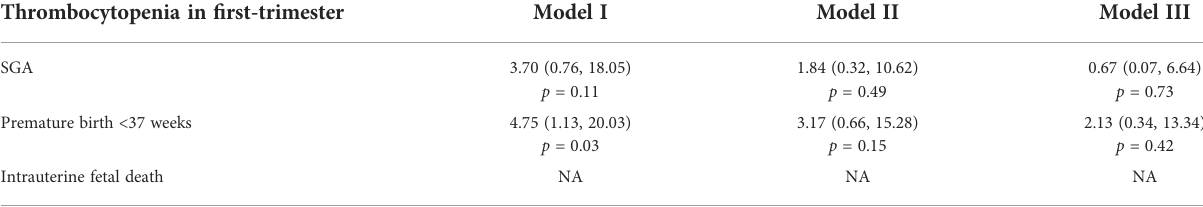
SGA, small for gestational age. AdjustImodeladjustfor:age;previousabortionhistory;pregnancybyarti fi cialinsemination;hypocomplementemia;Hightiterof2gp1and/orACL;aspirin+lowmolecularweightheparin. Adjust II model adjust for: age; previous abortion history; pregnancy by arti fi cial insemination; hypocomplementemia; high titer of a b 2GPI and/or aCL; pred; IVIg. AdjustIIImodeladjustfor:age;previousabortionhistory;pregnancybyarti fi cialinsemination; hypocomplementemia;hightiterofa b 2GPIand/oraCL;pred;HCQ;aspirin;lowmolecular weight heparin; aspirin+low molecular weight heparin; IVIg. NA, Not